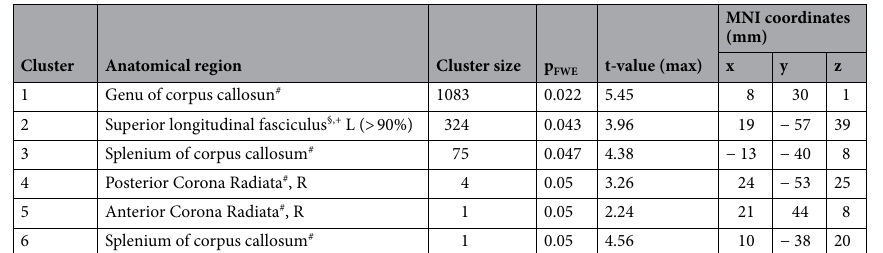
Table 3. Voxel-wise analysis of the interaction effect Group *IL-1β. # JHU ICBM-DTI-81 White Matter Atlas. § Not classified in JHU ICBM-DTI-81 White-Matter atlas. + XTRACT HCP Probabilistic Tract Atlases. Clusters with p FWE ≤ 0.05 are displayed. L left hemisphere, R right hemisphere, MNI Montreal Neurologic Institute, p FWE family-wise error corrected p value.